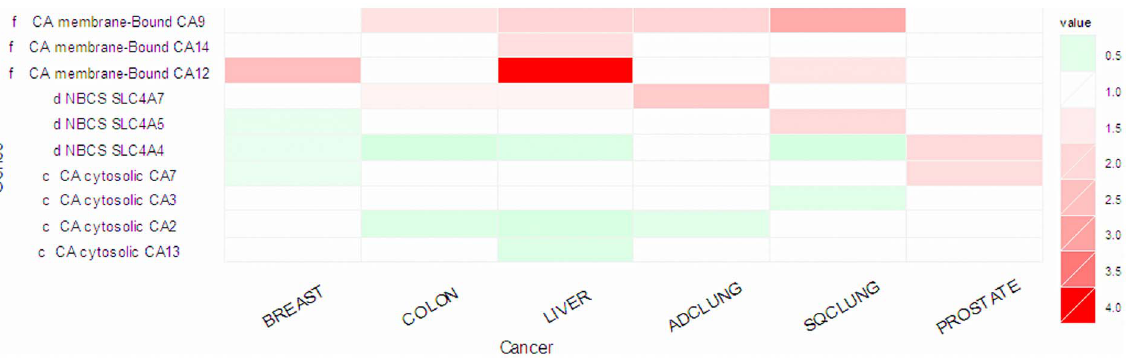
Figure 2. Expression level changes of genes involved in carbonic anhydrases (CAs) pH regulation in six cancer tissues in comparison with their matching control tissues.